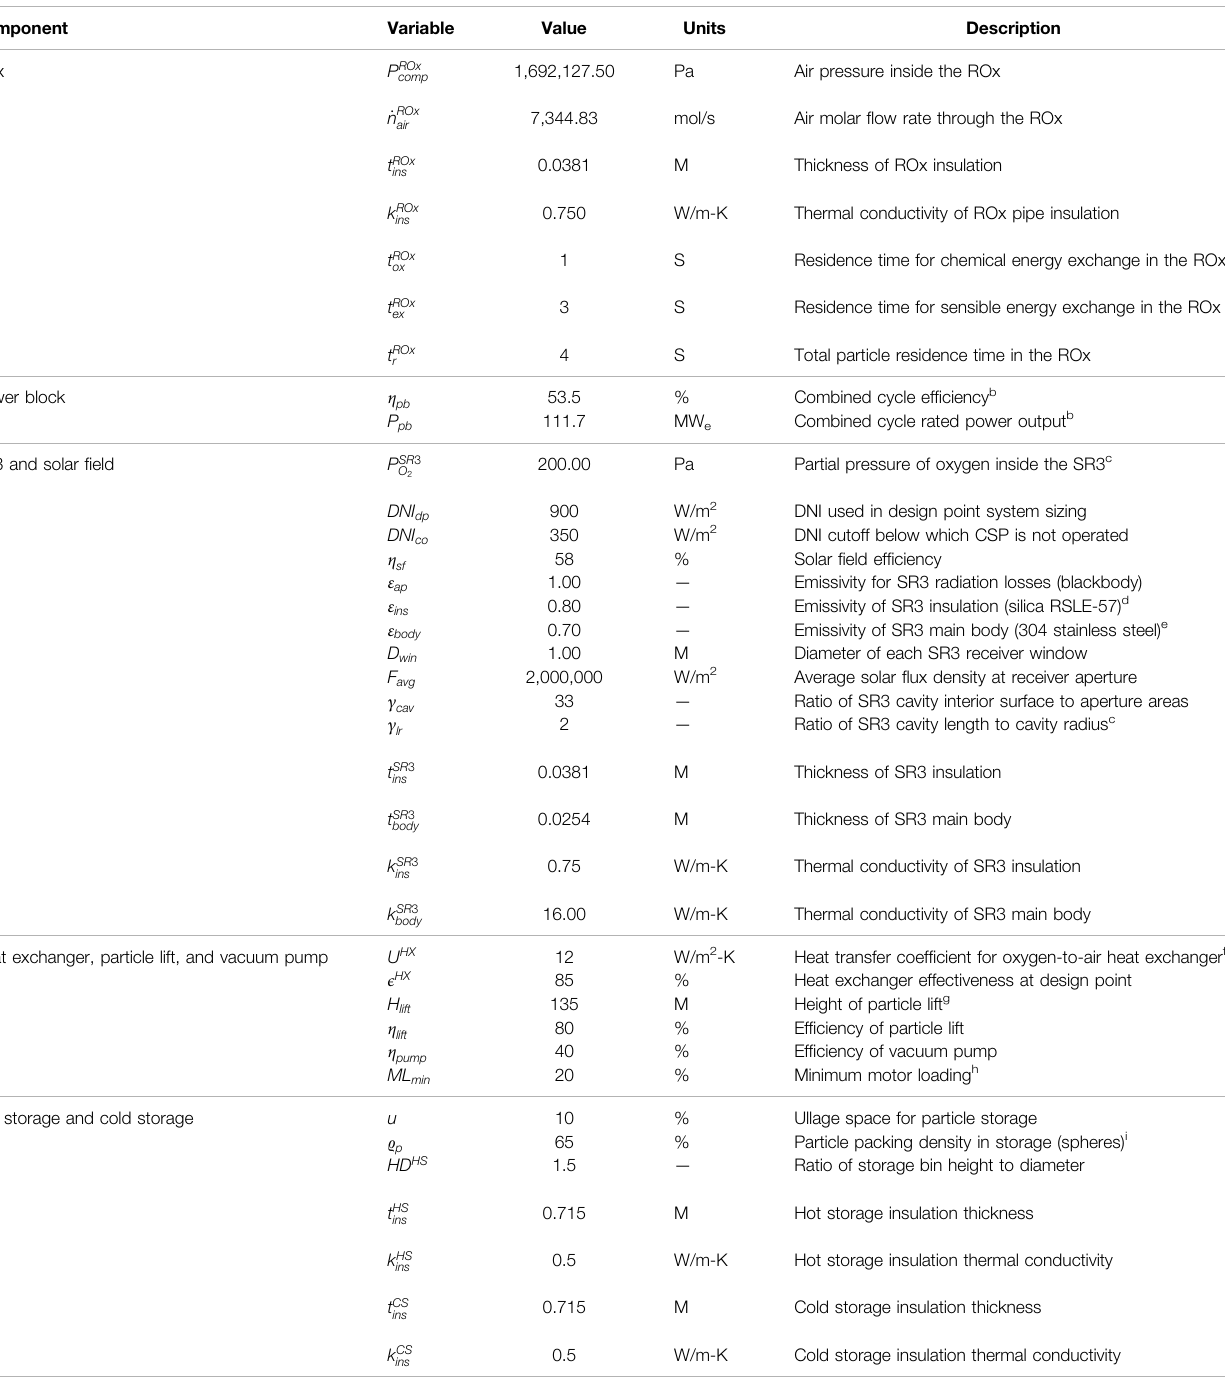
TABLE 3 | Component speci fi